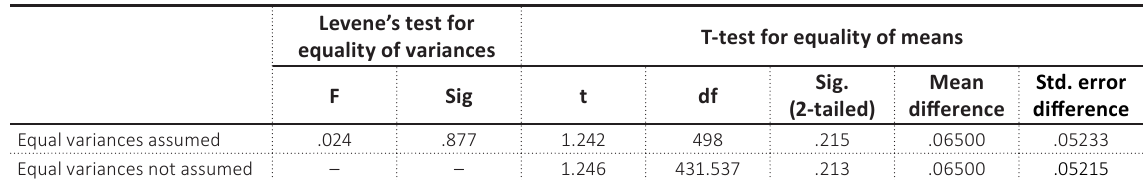
Table 9. Result of testing the difference by work